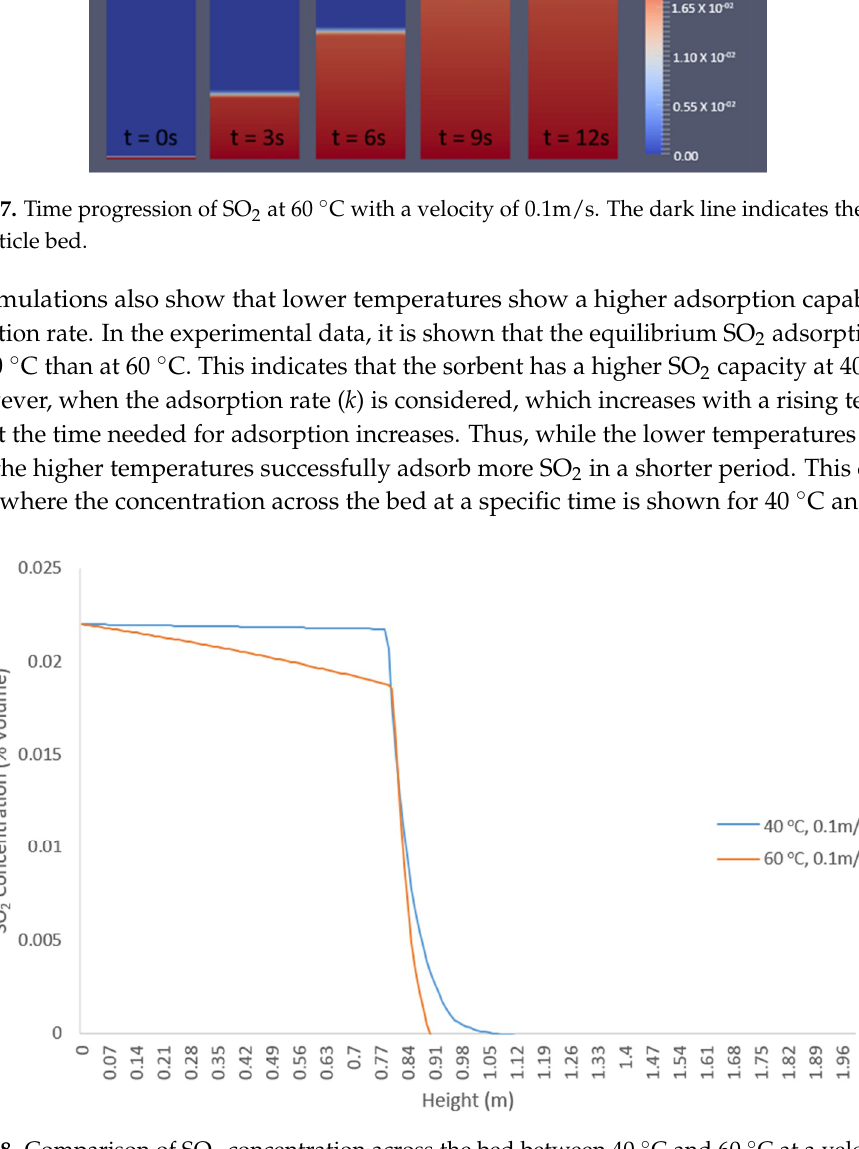
Figure 7. Time progression of SO 2 at 60 ° C with a velocity of 0.1m/s. The dark line indicates the top of the particle bed.